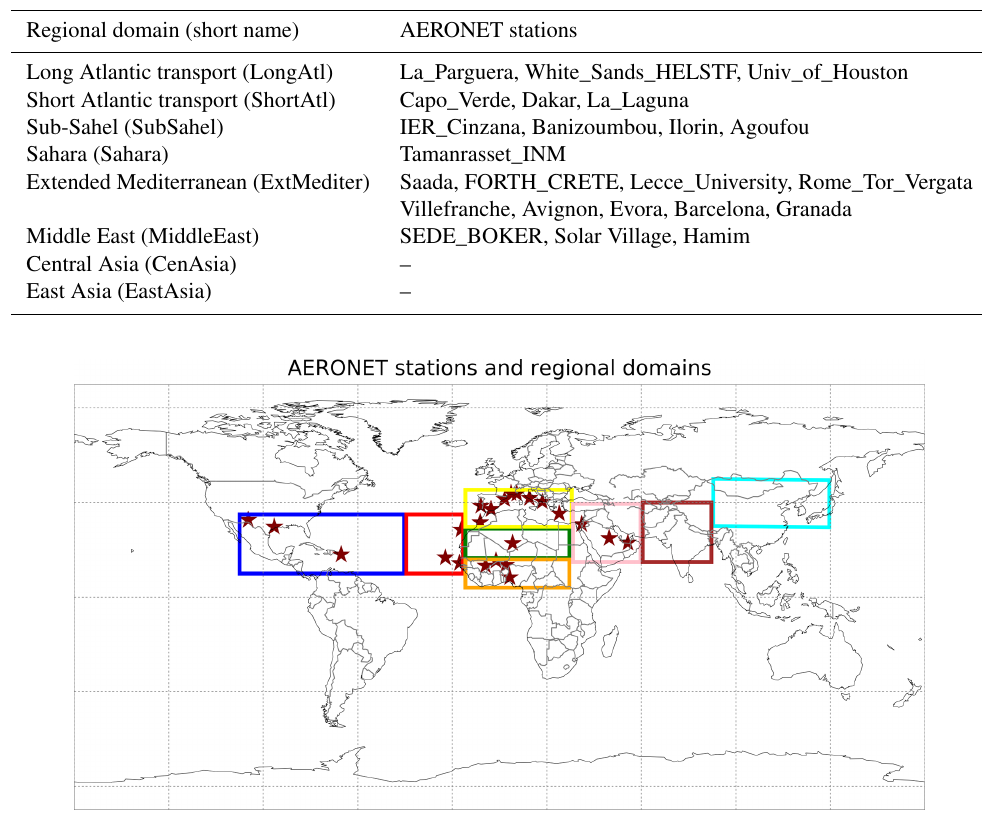
Figure 5. Map of AERONET stations and of the different regional domains used for validation purposes. The regional domains are indicated with different colours: Long Atlantic transport (LongAtl) in blue, Short Atlantic transport (ShortAtl) in red, Sub-Sahel (SubSahel) in orange, Sahara (Sahara) in green, Extended Mediterranean (ExtMediter) in yellow, Middle East (MiddleEast) in pink, Central Asia (CenAsia) in granada, and East Asia (EastAsia) in